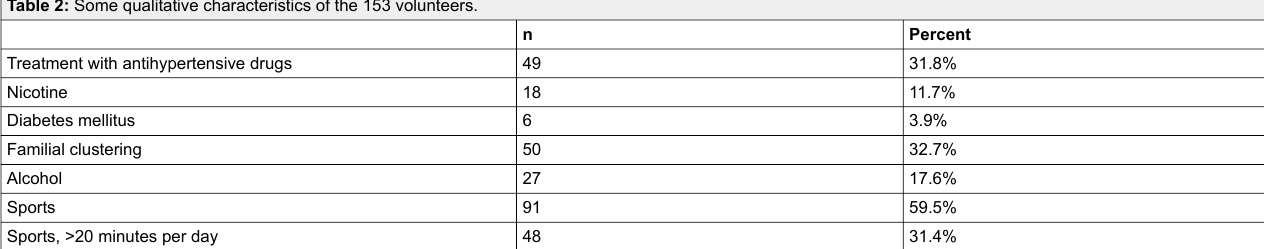
Table 2: Some qualitative characteristics of the 153 volunteers.